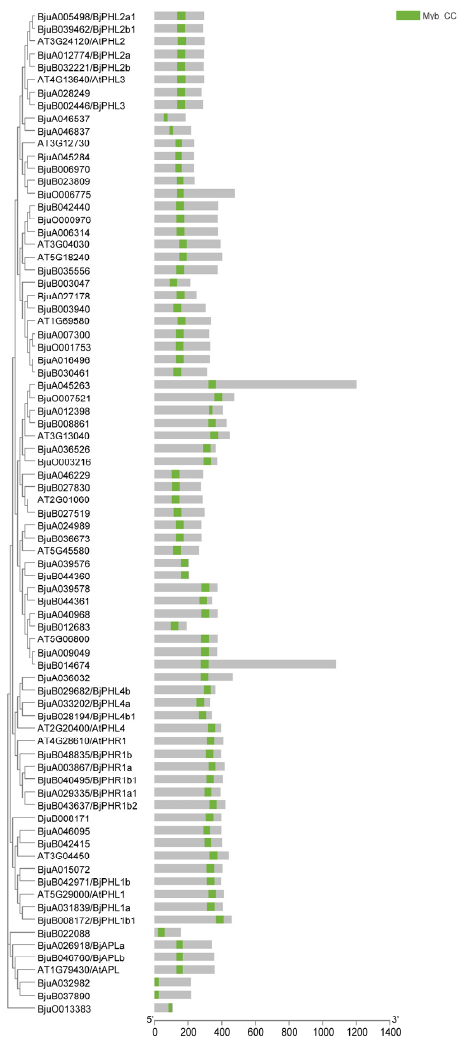
Figure 4. Protein architecture of the MYB-CC proteins in Brassica juncea and Arabidopsis thalina . The distribution of the conserved MYB-CC motif is represented by green-colored box. See Table S3 for detailed motif